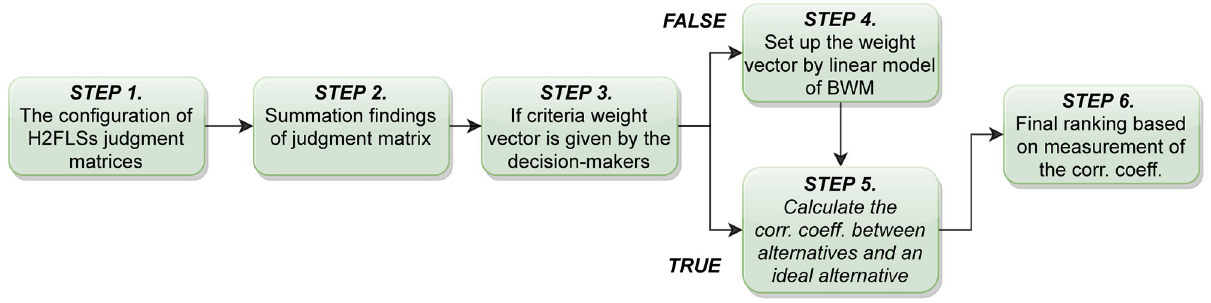
Fig 2. An algorithm for solving the problem using the proposed corr.